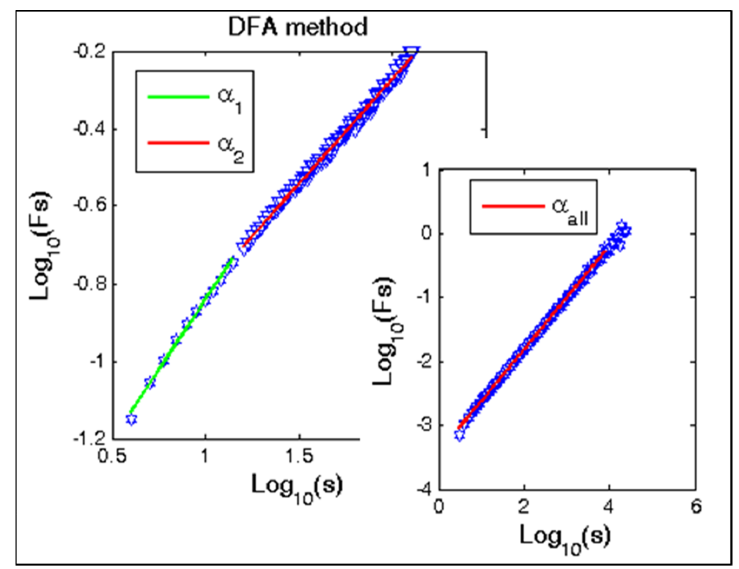
Figure 3. DFA method for determining the Hurst exponent.